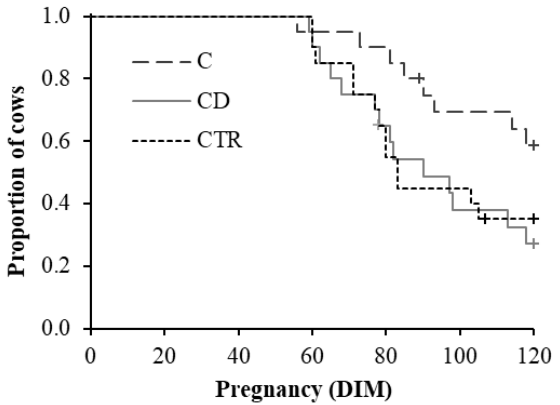
Figure 5. Kaplan–Meier survival plot showing the proportion of cows over DIM (days in milk) that became pregnant within 120 DIM in the three treatment groups (C = ceftiofur; CD = ceftiofur + ketoprofen; CTR = control) of 20 cows each. Censored values are reported (+). Particularly, cows of CD and CTR groups became pregnant 14 and 19 days sooner, respectively, than cows of the C group (Table 2). Moreover, CD cows were 2.8 times more likely to be pregnant within 120 DIM than C ones (Table 2). Table 2. Least square means (LSM) and standard errors (SE) of days in milk (DIM) at pregnancy in the three treatment groups, CD (ceftiofur + ketoprofen), C (ceftiofur), and CTR (control), of 20 cows each, as resulted from the survival analysis. Hazard ratio (HR) and 95% CI of becoming pregnant within 120 DIM, as resulted from the Cox proportional hazard model for both the com- parisons (CD and C vs. CTR, and CD vs. C), are reported too. CD and C vs. CTR